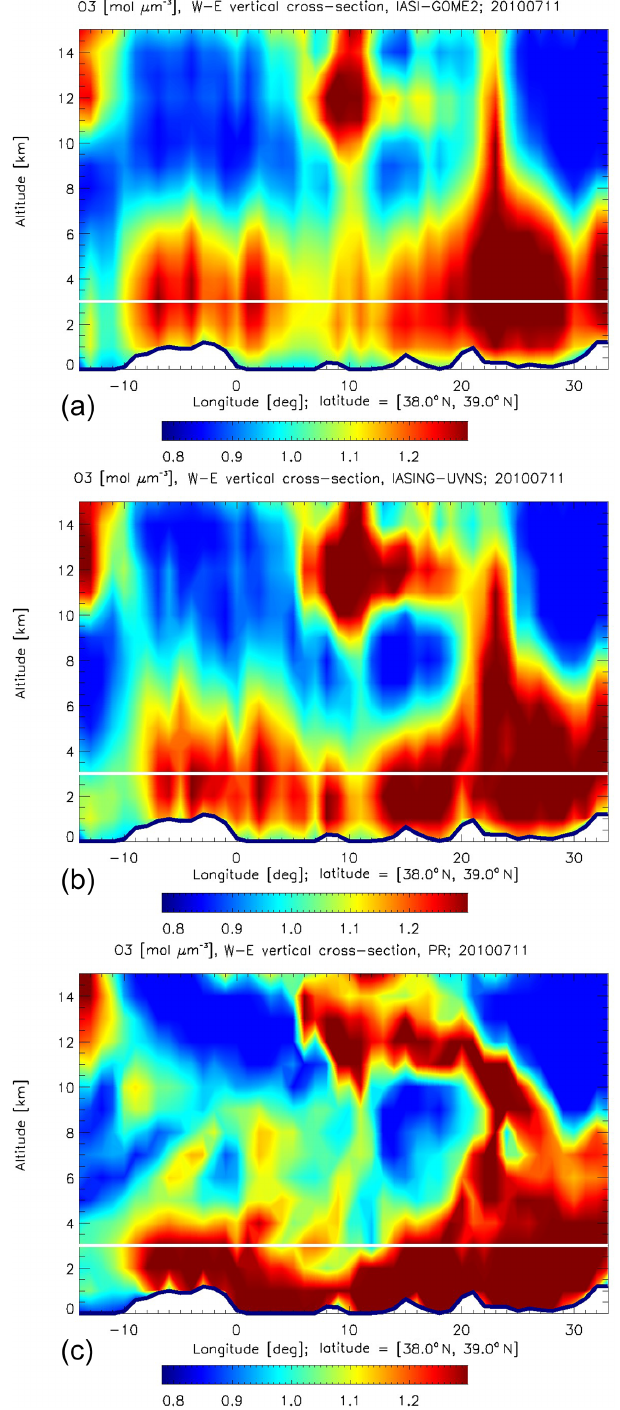
Figure 10. Same as Fig. 9, but for 11 July 2010.